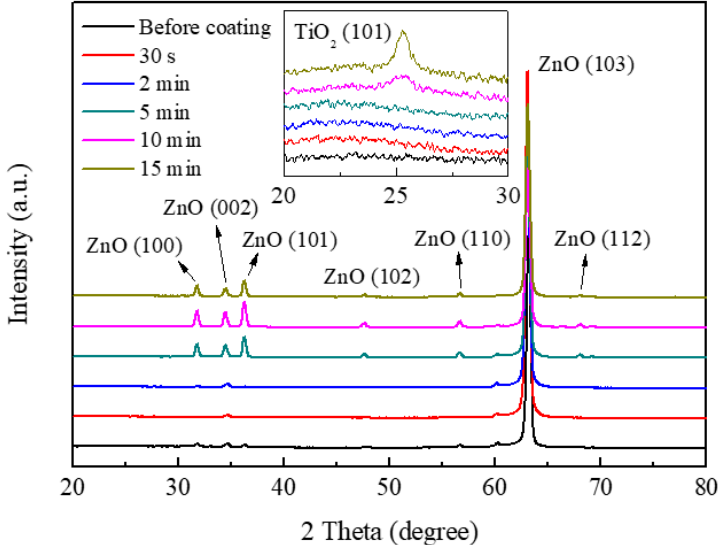
Figure 4. Grazing incidence X-ray diffraction (GIXRD) patterns of the as-deposited ZnO nanorods and ZnO nanorods coated with TiO 2 by mist CVD.